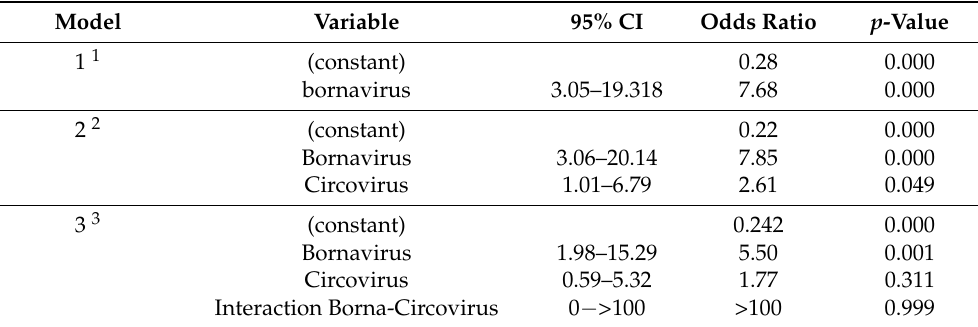
Table 6. Results of logistic regression analysis with occurrence of proventricular dilatation disease (PDD)-like signs as the dependent variable. Estimates were calculated using virus test status as independent variables (bornavirus in model 1, bornavirus and circovirus in model 2, bornavirus, circovirus, and interaction in model 3). p -values < 0.05 were regarded as significant.